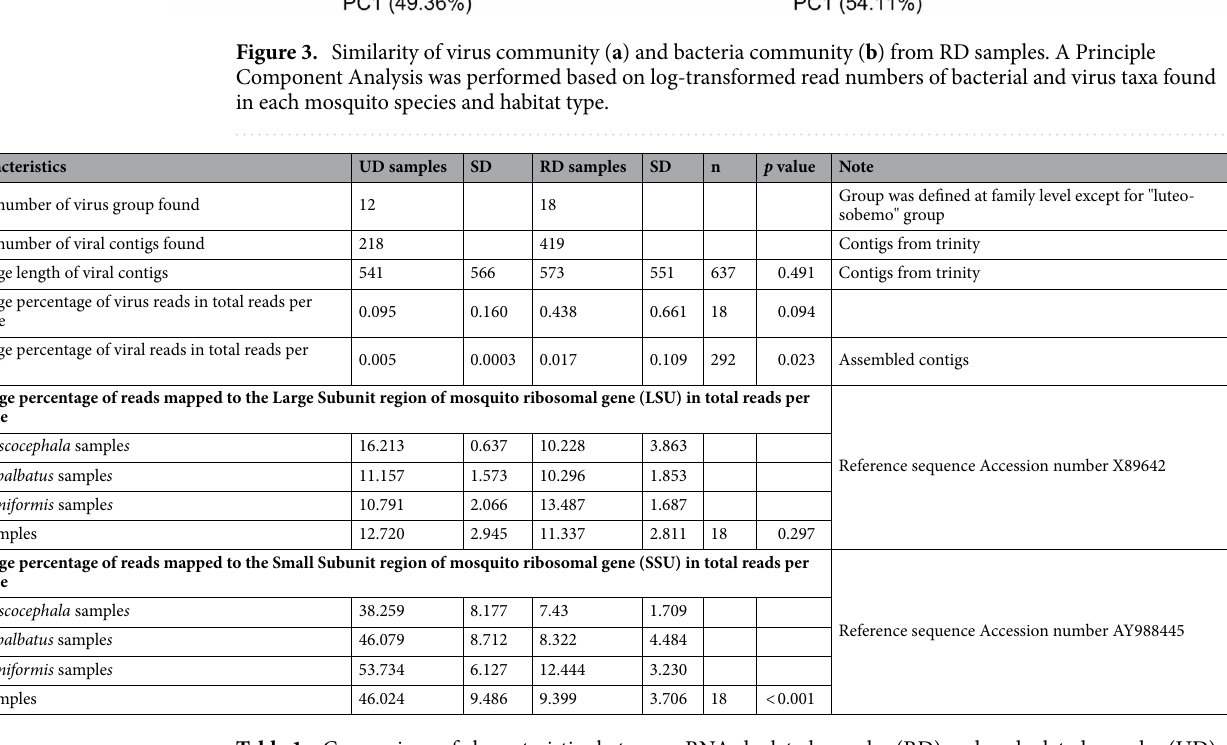
Table 1. Comparison of characteristics between rRNA-depleted samples (RD) and undepleted samples (UD). Statistical analysis was performed using Mann–Whitney U